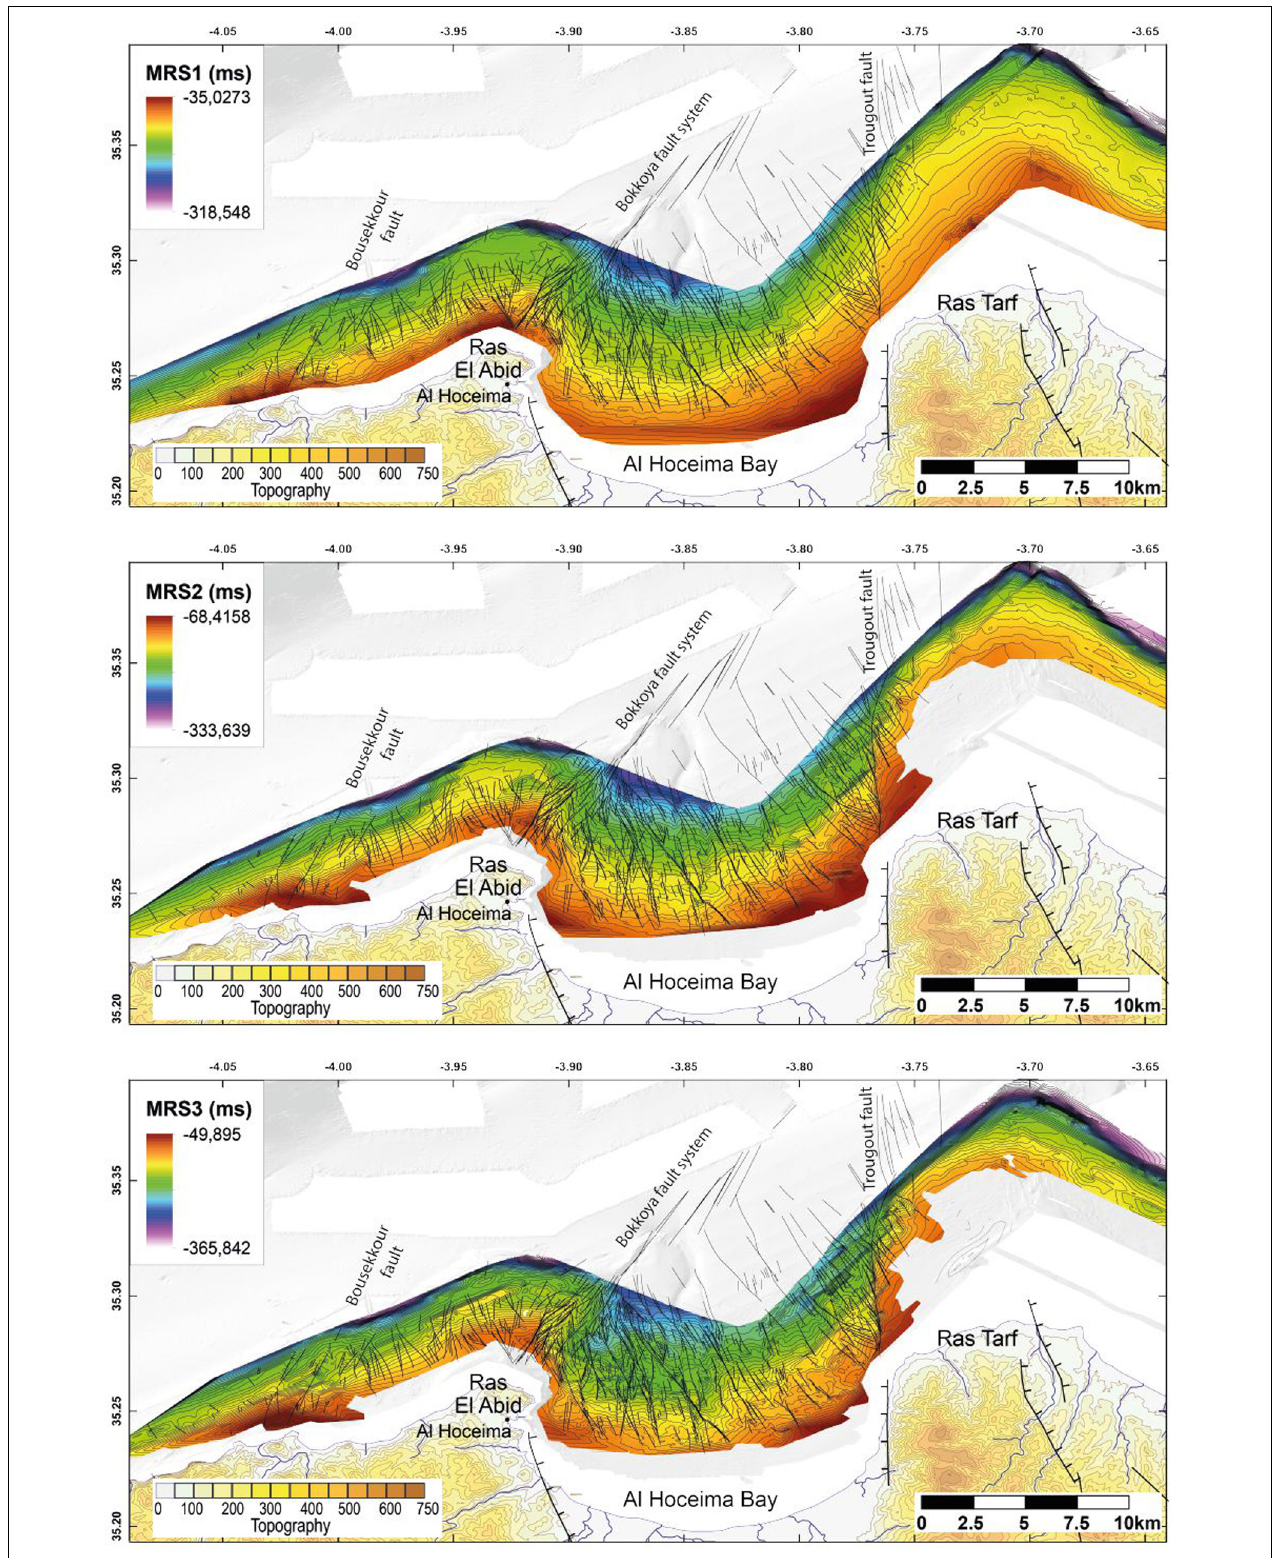
FIGURE 4 | Marine regressive surfaces (MRS) used for the throw analysis. The fault traces considered are also depicted.